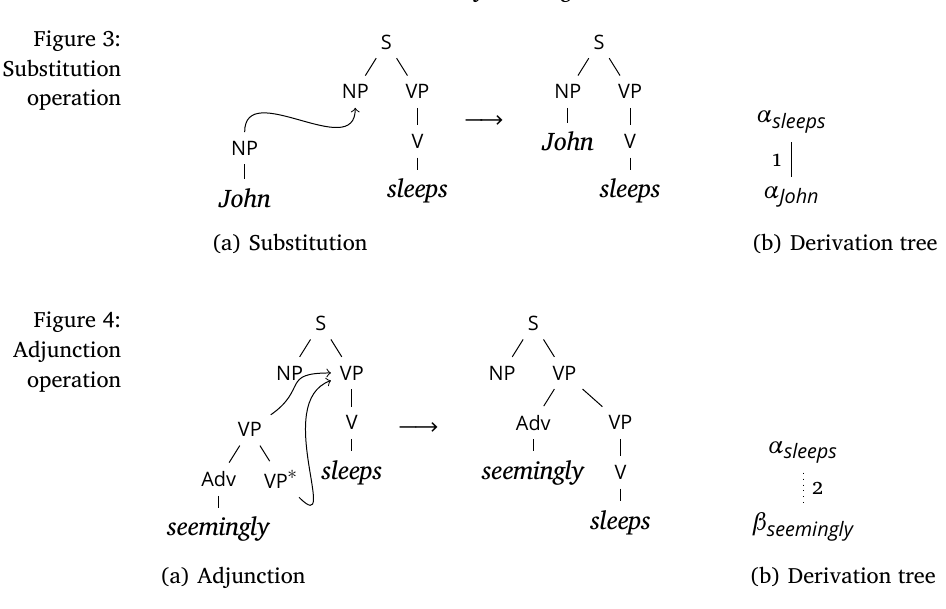
Substitution operation